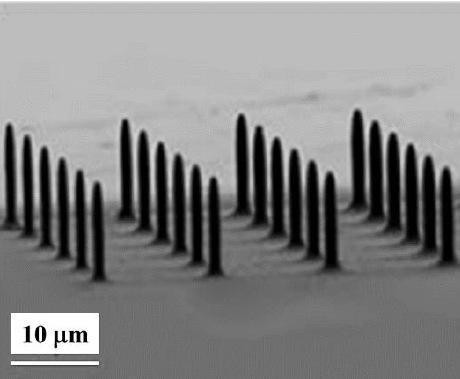
Figure 1. Micropillars on a copper part printed in a single step by FluidFM 3DP method [11].